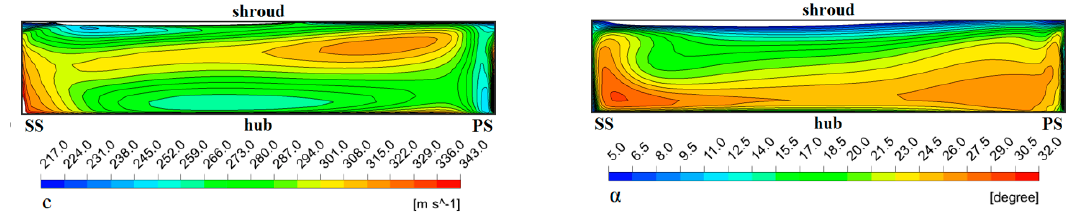
Figure 14. Absolute velocity and angle at impeller exit in the relative frame of reference, point P1.